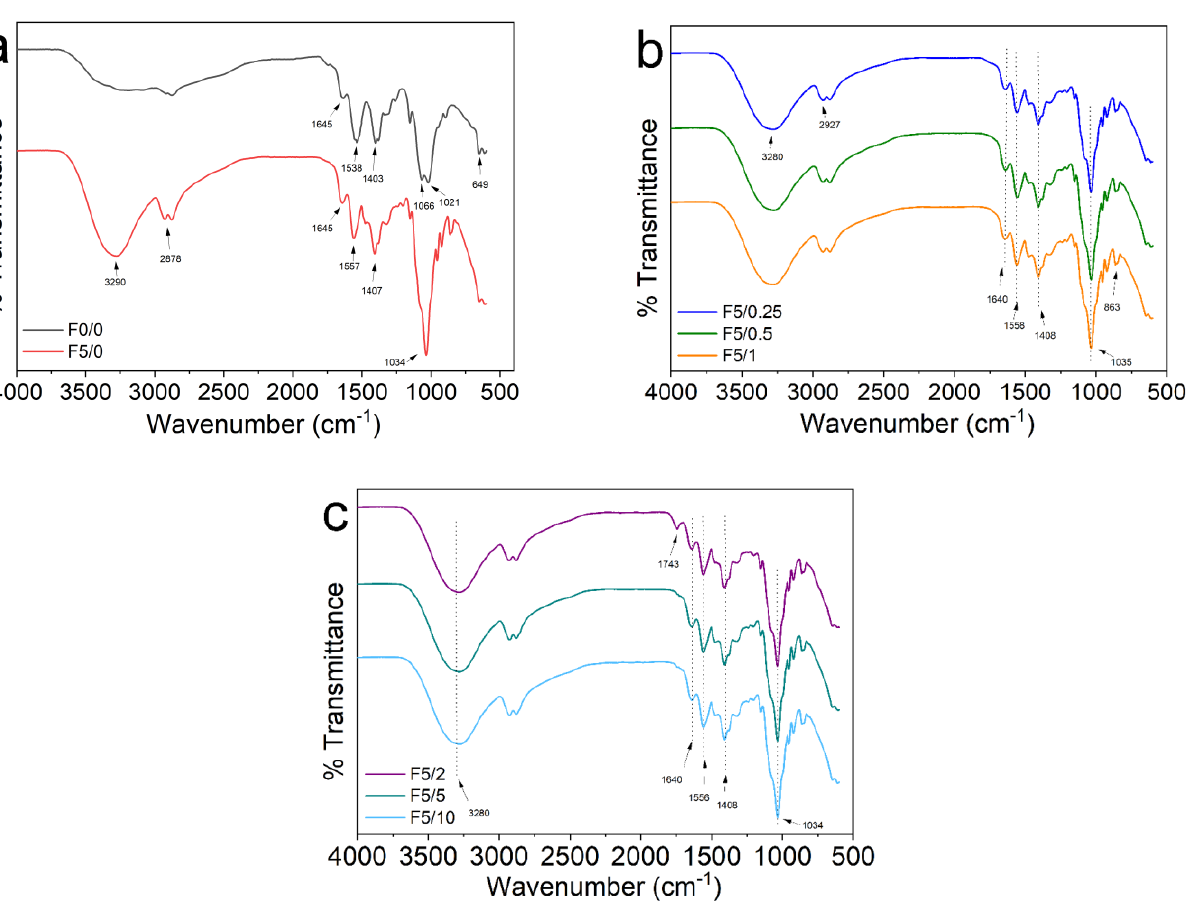
Figure 4. FTIR spectra for ( a ) pure CS (F0/0) and CS-DES (F5/0), ( b ) F5/0.25, F5/0.5 and F5/1, and ( c ) F5/2, F5/5 and F5/10.